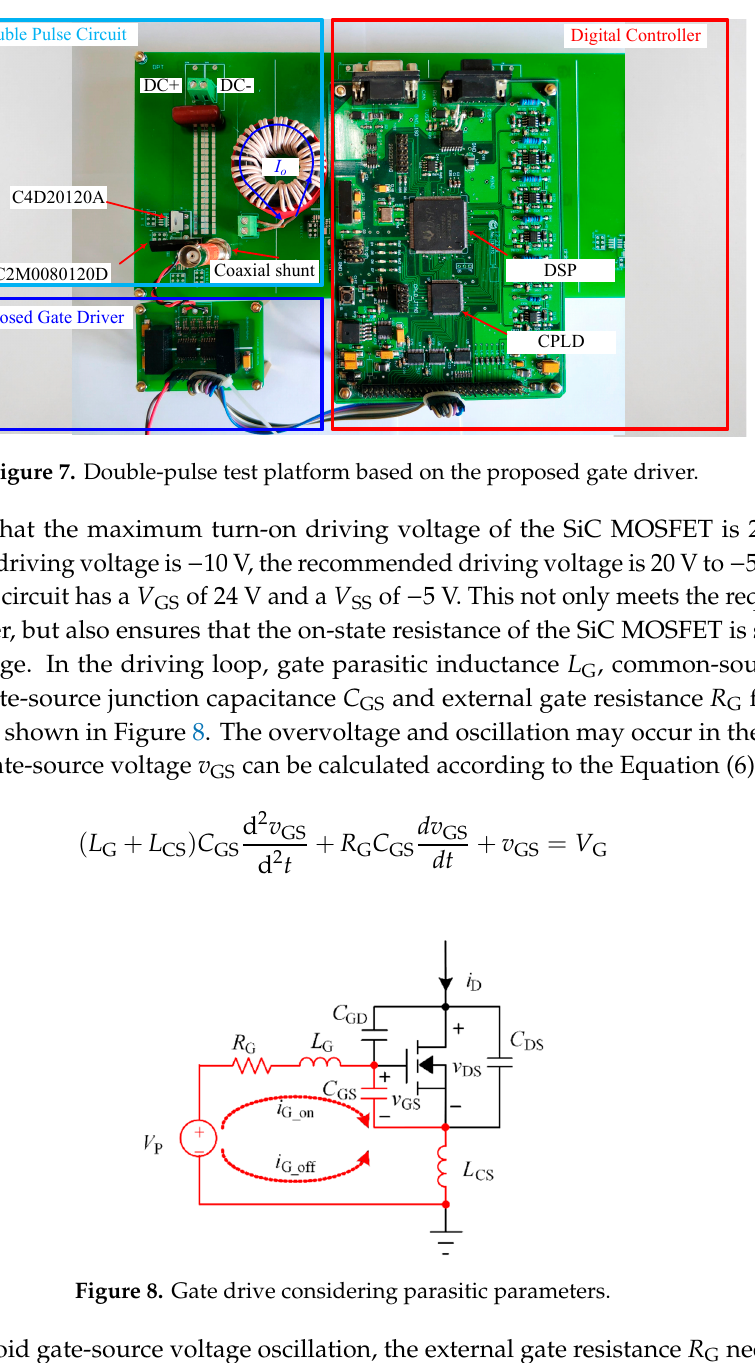
Figure. 8 Gate drive considering parasitic parameters. Figure 8. Gate drive considering parasitic